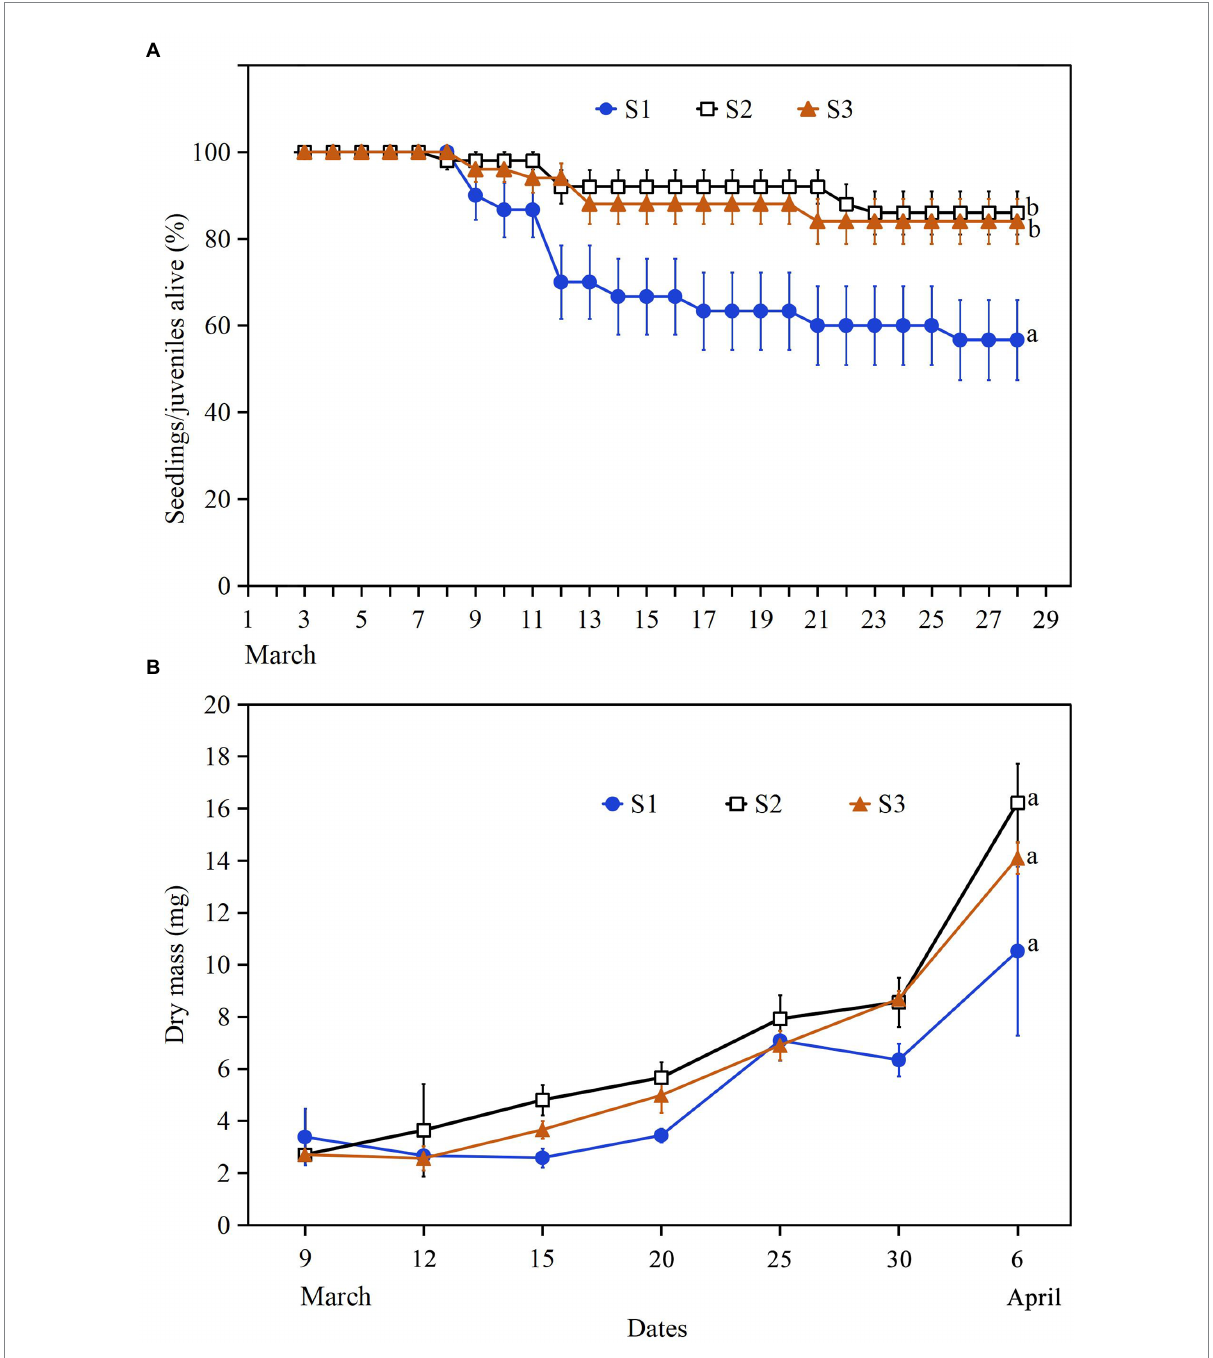
FIGURE 5 Percentages (mean ± SE) of seedlings/juveniles alive (A) and dry mass of seedlings (B) of Salsola brachiata in spring 2022. S1, seedlings from plant- germinated seeds; S2, seedlings from soil-germinated seeds that dispersed before snow in autumn 2021; S3, seedlings from soil-germinated seeds that dispersed in winter 2021 and at snowmelt in early spring 2022. Different lowercase letters indicate significant differences in final percentage survival (A) or final dry mass (B) of S1, S2, and S3